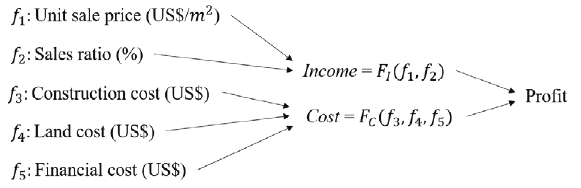
Figure 2. Generation model concept